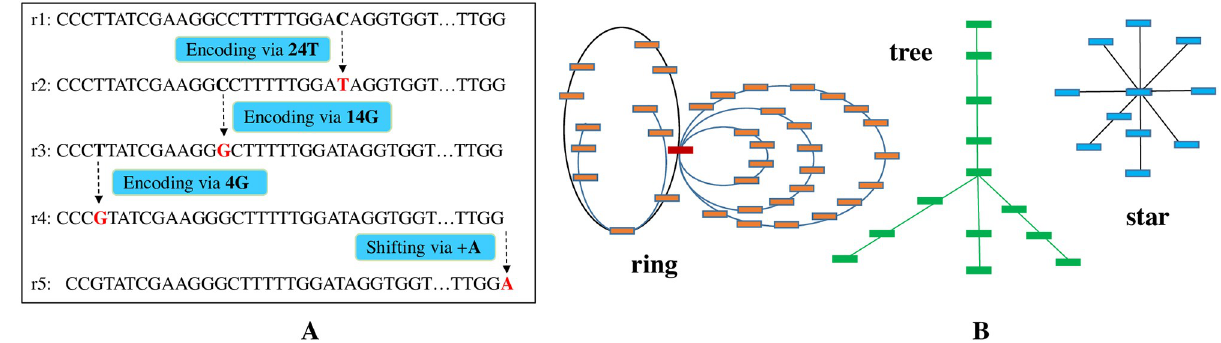
Fig 1. Illustration of mutually referred reads in a path, and various HaS-graph sub-structures. (a) A path containing 5 reads (of the same length 100) for the encoding of r2, r3, r4 and r5. (b) Various types of sub-structures of reads: ring, tree and star.